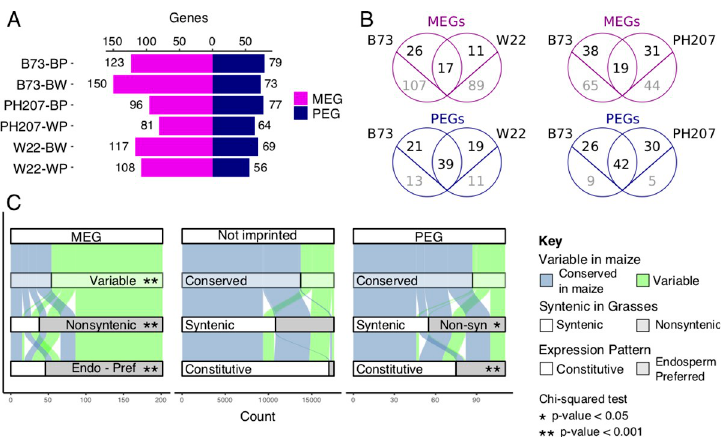
Fig 2. Imprinting of genes defined by RER. A) The number of imprinted genes identified across contrasts using the RER method (see Materials and Methods). MEGs are shown in magenta and PEGs are shown in blue. B) The overlap between imprinted genes across pairwise contrasts. Genes that are shared between genotypes that could be assessed for imprinting are shown in black above the line while imprinted genes unique to one genome are shown in gray below the line. C) Comparison of features for MEGs, PEGs, and non-imprinted B73 genes. Genes are defined as conserved when they are shared with all genotypes present in this study, syntenic when a syntenic ortholog exists in sorghum, rice, foxtail millet, and brachypodium, and endosperm-preferred if expression is primarily restricted to the endosperm (S5 Fig). Asterisks denote significance relative to the Not Imprinted set (chi-squared